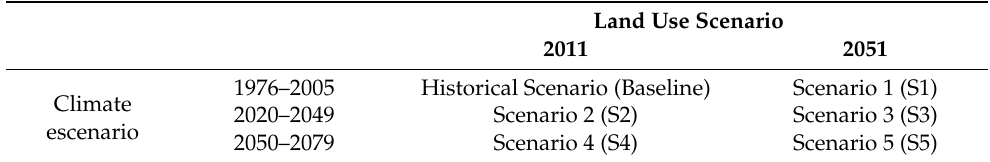
Table 2. Simulated scenarios of land use and climate